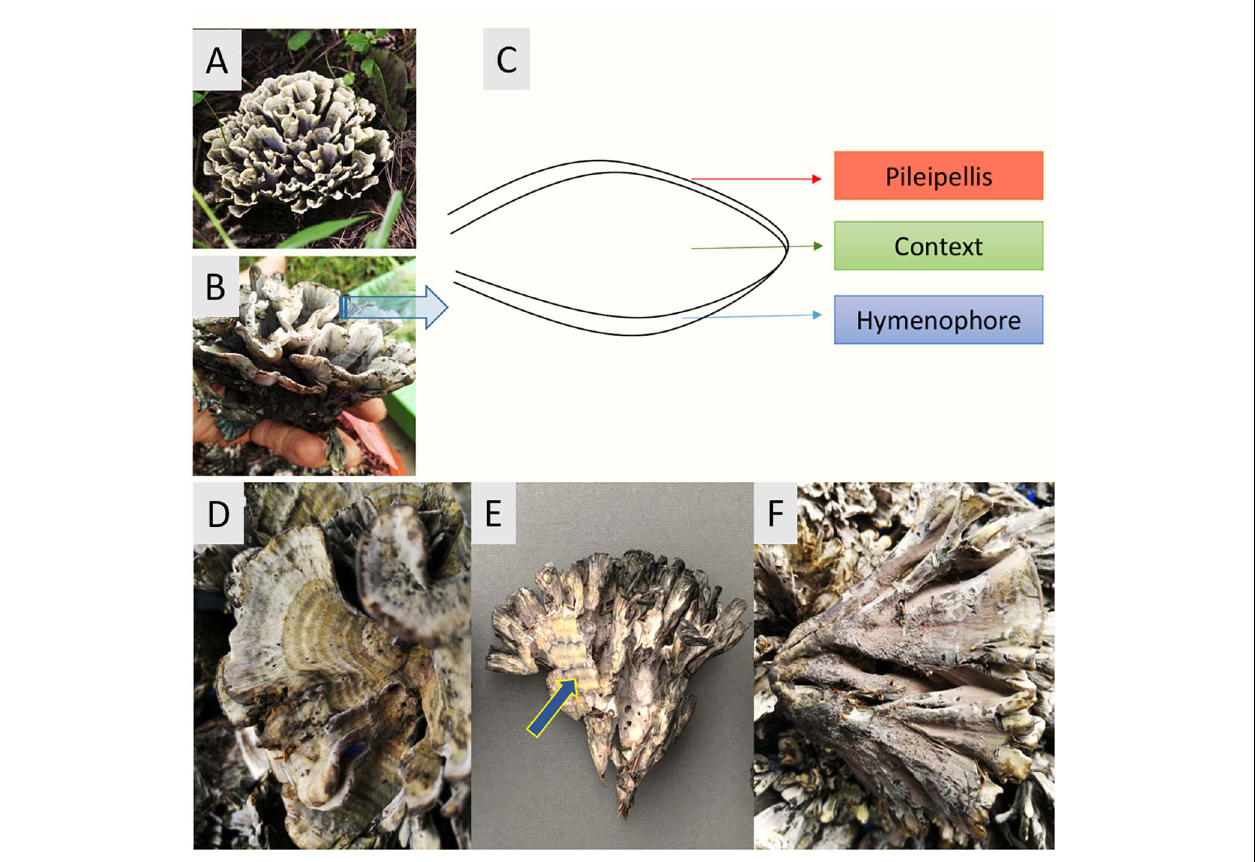
FIGURE 1 | Thelepora ganbajun sporocarps and their compartments. (A,B) General views of the whole thelephoroid sporocarp growing in Pinus yunnanensis forest, its natural habitat. (C) Cross section diagram of the three sporocarp compartments. Close-ups of the pileipellis (D) , context (blue arrow) showing concentric zones (E) , and hymenophore (F)